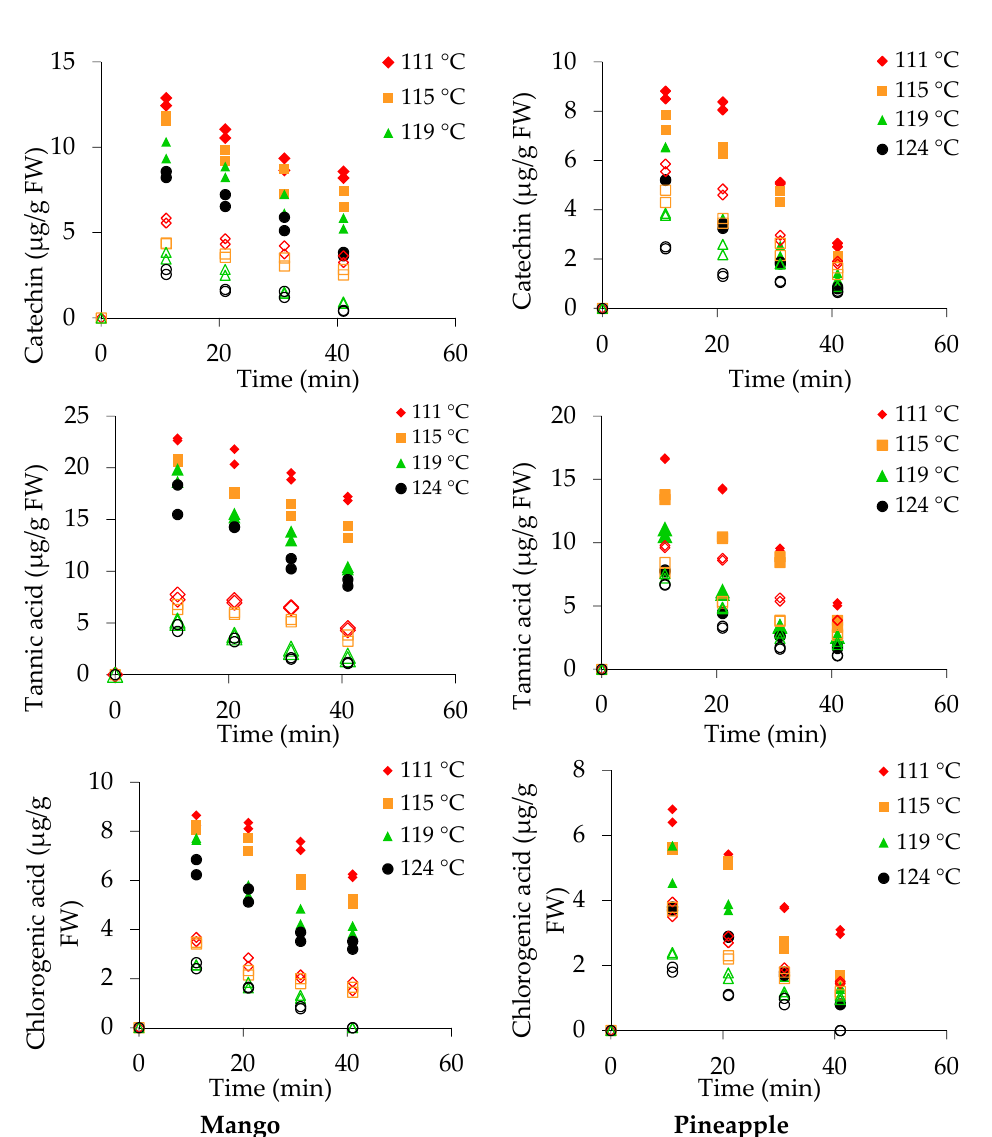
Figure 2. Catechin, tannic acid, and chlorogenic acid concentrations in mango and pineapple pieces (closed symbols) and syrup (open symbols) during canningat different temperatures.